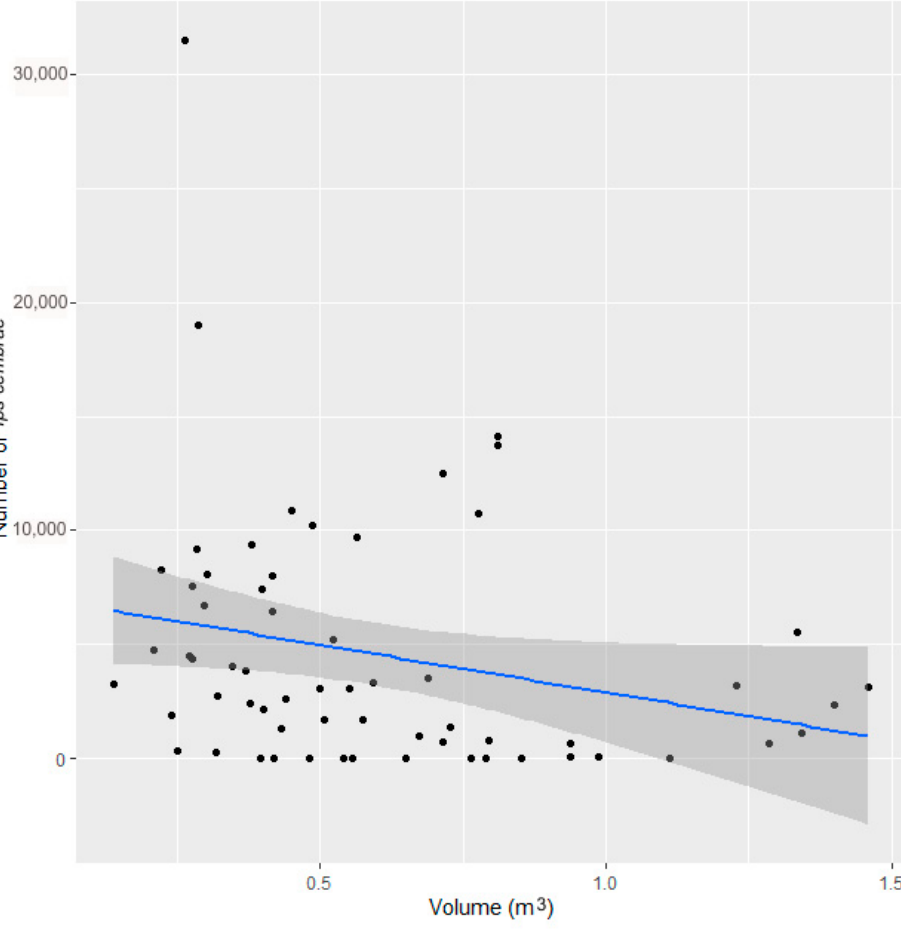
Figure 7. Relationships between the number of I. cembrae (points) per trap tree and wood volume per trap tree in experiment 3.